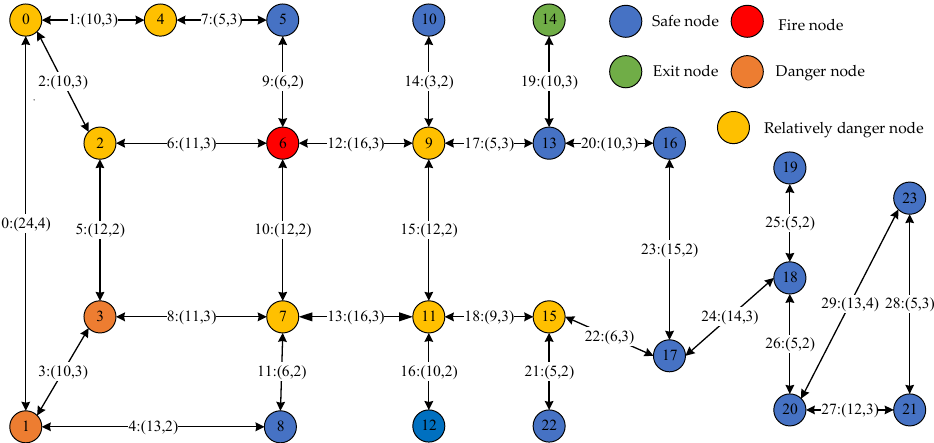
Figure 3. Cruise ship evacuation network topology of the 200th second of the fire.